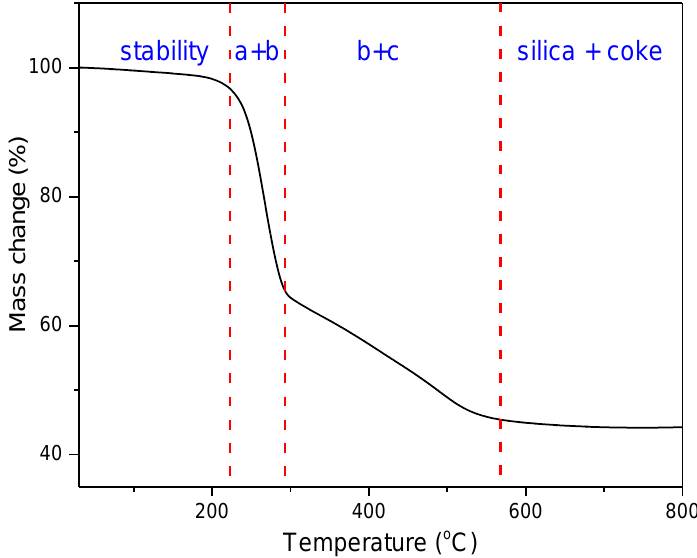
Figure 5. Overview of the complex process of thermal changes of POSS (on the example of iBu7SS-H).